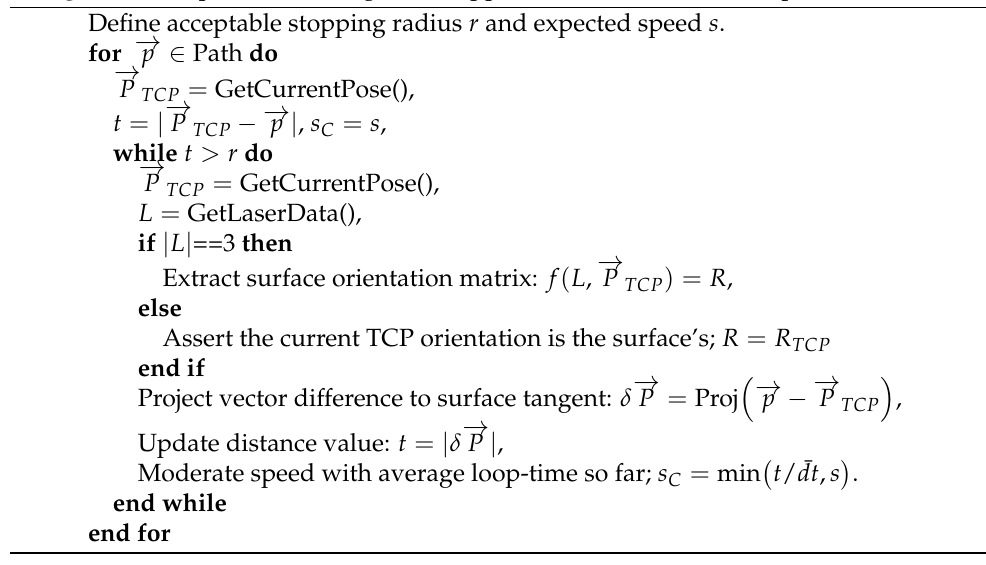
Algorithm 2: Speed control algorithm applied to reach each control